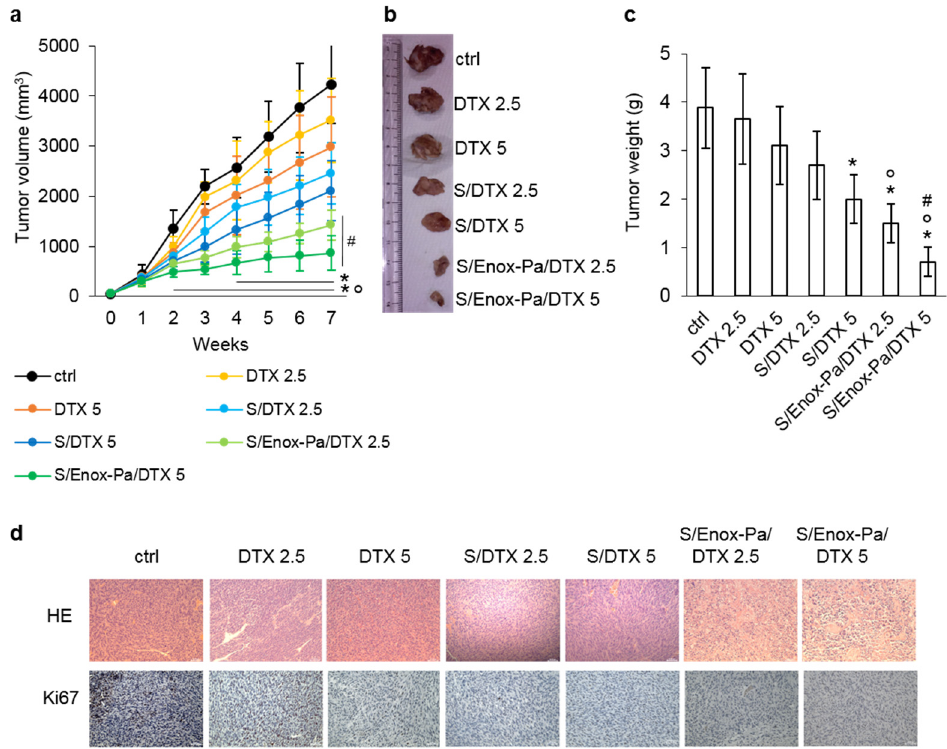
Figure 4. Enox-coated SEDDS reduce the growth of drug resistant non-small cell lung cancer xenografts. First, 1 × 10 6 A549 cells were inoculated subcutaneously in the right flank of 6-week-old Balb/C female nude mice. When tumors reached the volume of 100 mm 3 , mice (n = 8/group) were randomized in the following groups and treated once a week for 6 weeks as reported: (1) vehicle group (ctrl), with 100 µL saline solution administered intravenously; (2) docetaxel 2.5 mg kg − 1 (DTX